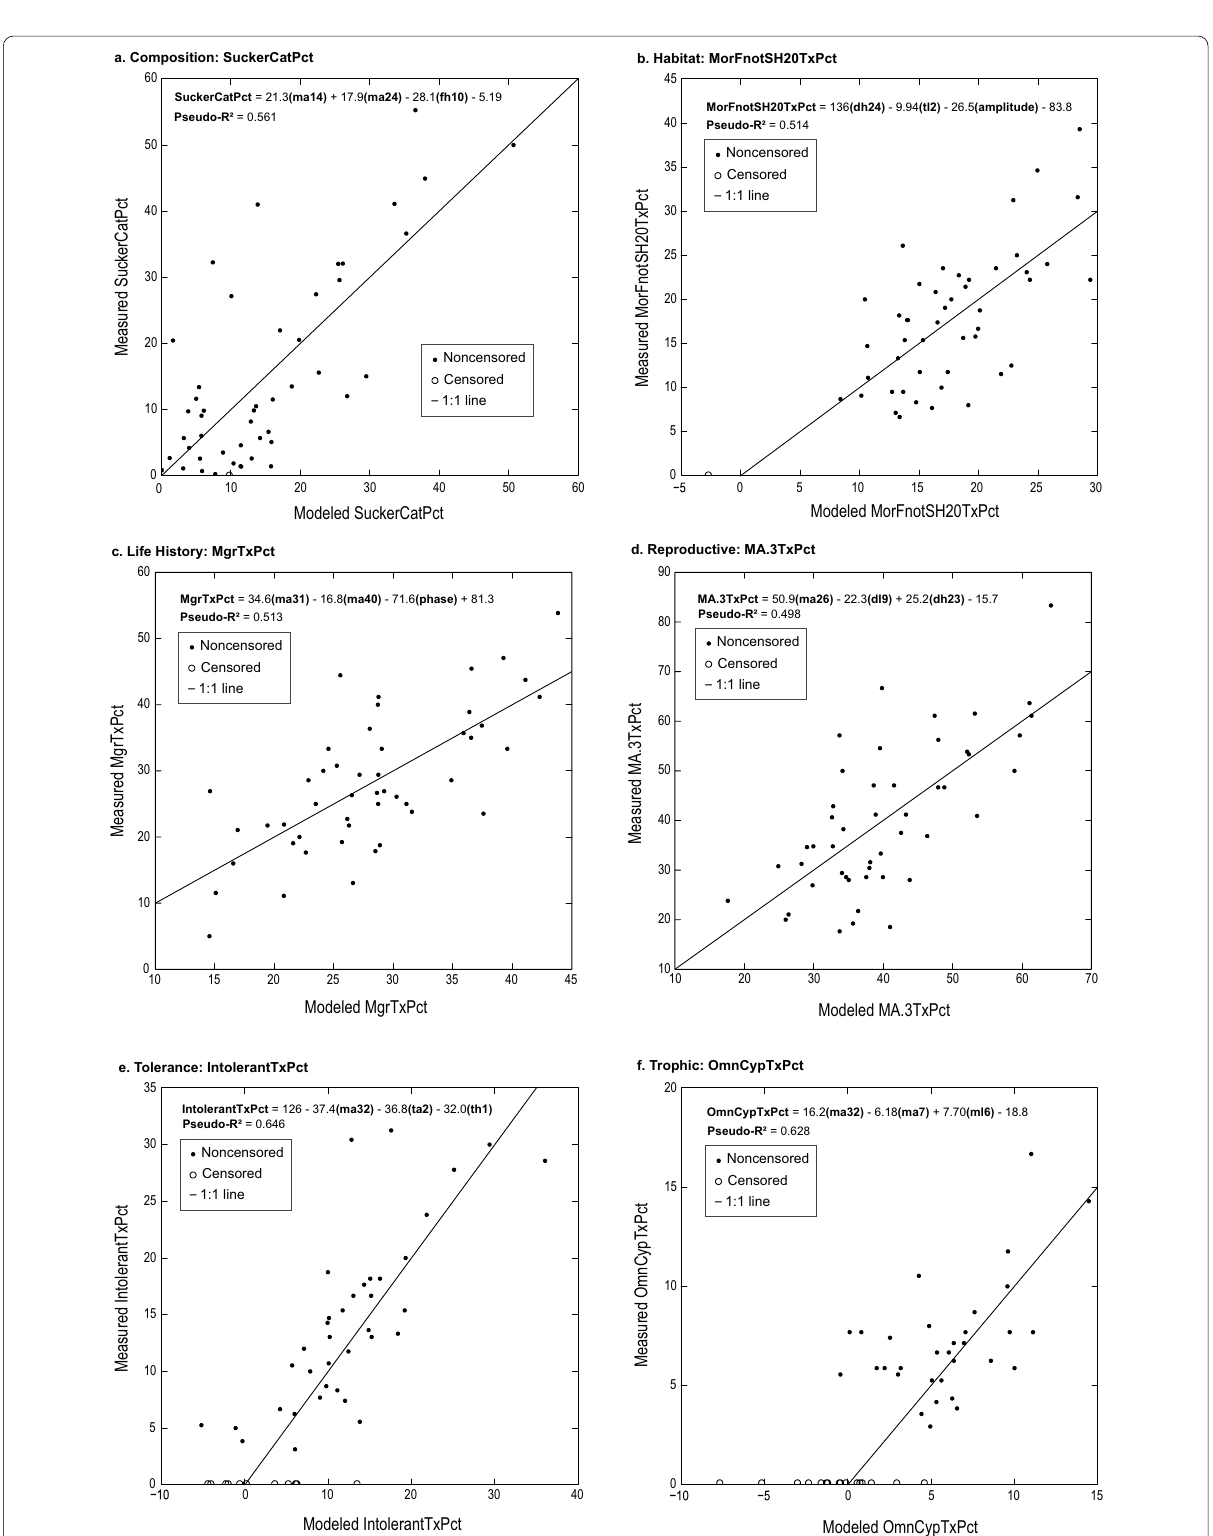
Fig. 5 Measured versus modeled value plots for the single best regression model in each of six biological metric categories and the short-term change (STC) hydrologic dataset as presented in Table 4 (Krall et al. 2022): a composition, b habitat, c life history, d reproductive, e tolerance, and